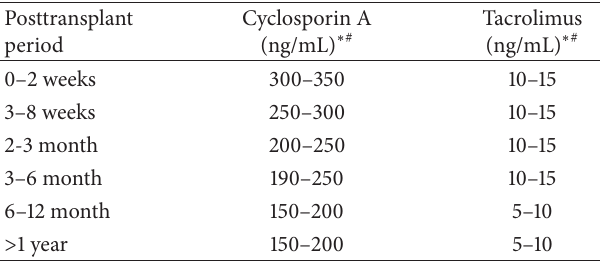
Table 4: Cyclosporin and Tacrolimus can be monitored by trough